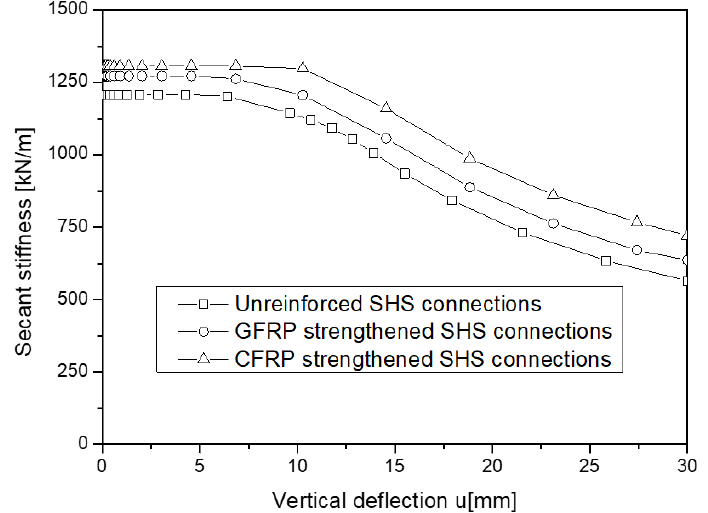
Figure 9. Secant stiffnesses versus displacements for the connections under static loading.